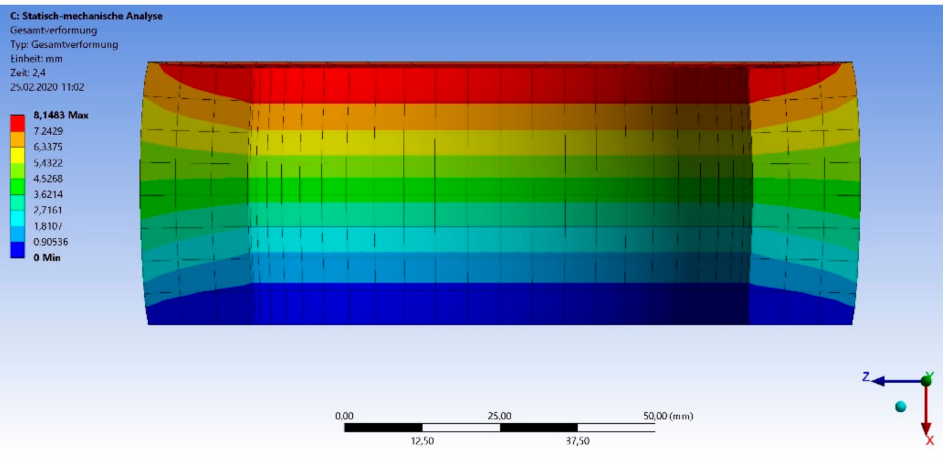
Figure 4. Simulation of the qualitative deformation of a ring-shaped sample of an aspect ratio close to three at room